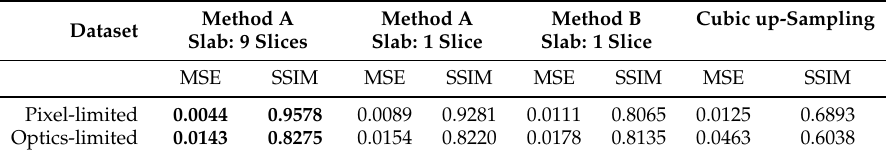
Table 3. Foam ball phantom: comparison of the MSE and SSIM between the output of the three approaches described in this section and cubic up-sampling. For each dataset and metric, the best results are shown in